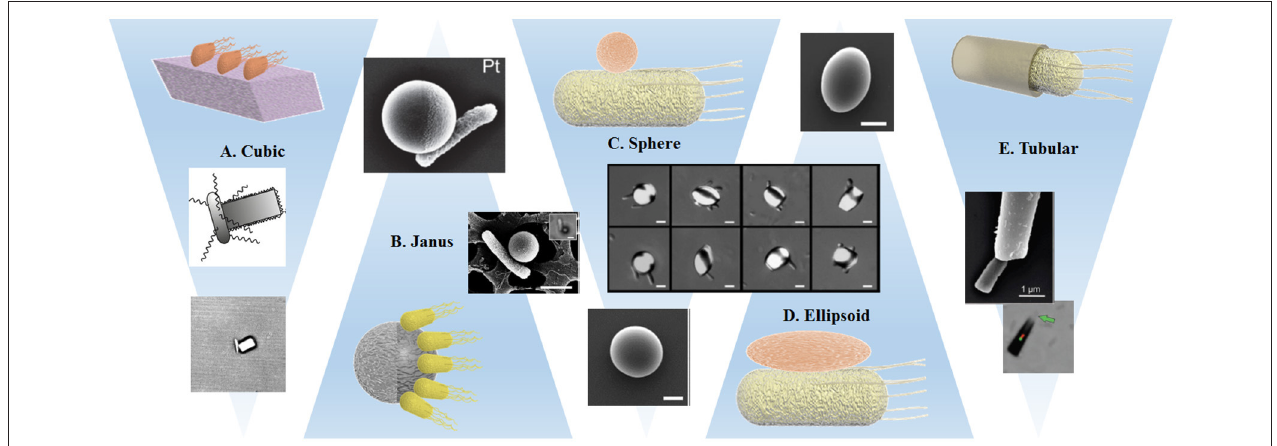
FIGURE 4 | Schematic representations and examples of the interaction of bacteria with variously shaped cargoes: (A) Single bacterium attached by optical trapping to a cuboid elongated zeolite L crystal ( Barroso et al., 2015). (B,C) Preferential attachment of bacteria to spherical metal capped-PS Janus particles (Stanton et al., 2016 ) and Pluronic covered PS particles (Behkam and Sitti, 2008). (D) Bacteria attached to PS particles with different ellipsoidal body geometries (Sahari et al., 2012). (E) Bacteria captured inside a microtube regarding the bacteria driven microswimmer assembly ( Stanton et al., 2017a). All images presented with corresponding copyright